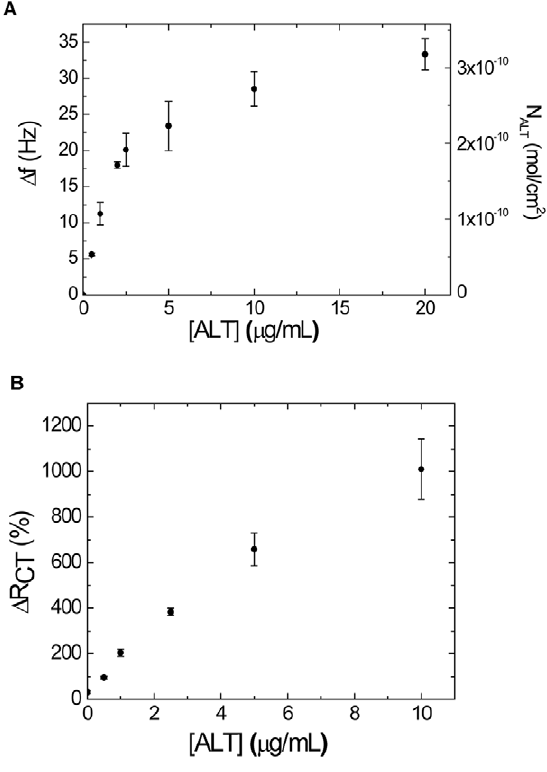
Figure 8. Response curves of ALT binding. Measurements were made using QCM (shown as absolute value of frequency change) (A) and EIS (B). Each run was performed using a single electrode with successive tests in ALT solutions from low to high concentration. The apparent amount of bound ALT (N ALT ) for the QCM measurements was calculated using Eqn. 3 and is shown on the right ordinate. Error bars represent standard deviations obtained from triplicate measurements.